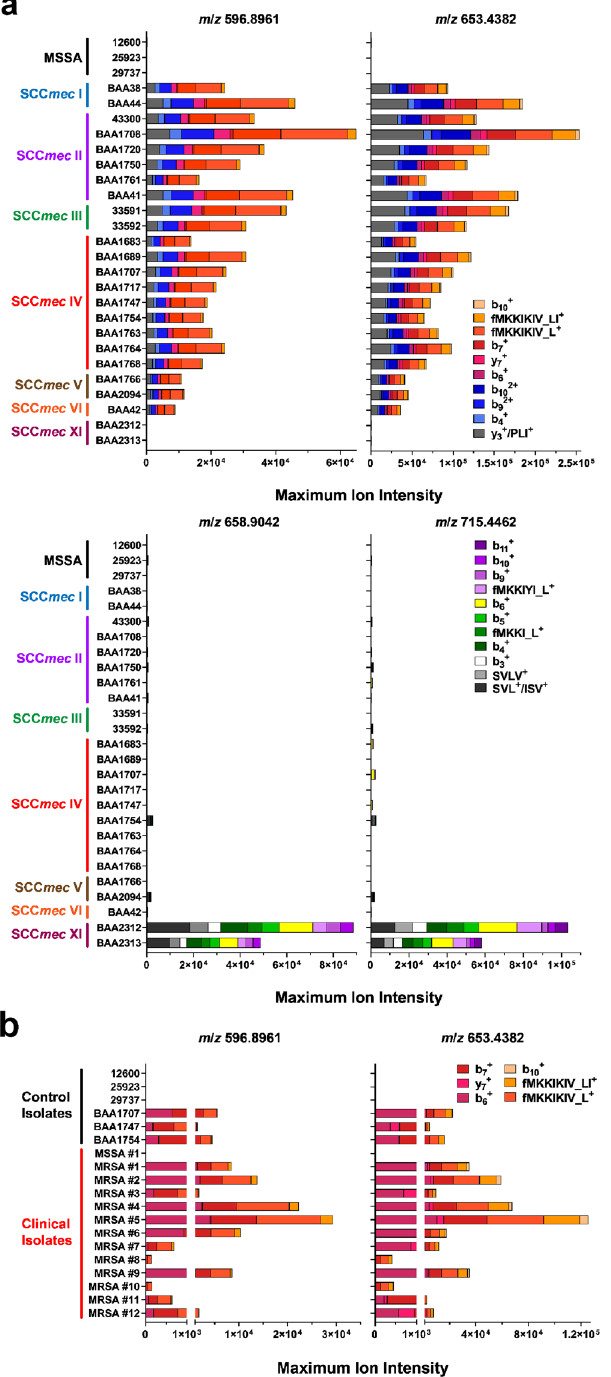
Figure 4. Evaluation of source-induced peptide detection of PBP2a across representative MRSA panel and clinical isolates. ( a ) Performance of source-induced detection method for PBP2a mecA (top panel) and PBP2a mecC (bottom panel) N-terminal peptide-like fragments for MRSA strains exhibiting different SCC mec and PFGE genetic backgrounds, as well as negative MSSA isolates (listed in Supplemental Table S6). Strains were cultured on TSA plates and harvest after overnight growth. Colored bars represent the mean maximum intensity for each product ion over a 60-min LC protein separation. Results are from distinct biological replicates (n = 3). ( b ) Performance of MSSA and MRSA quality control strains along with clinical isolates over five-minute PBP2a mecA detection method using custom SPE trap and source-induced dissociation method. Strains were cultured on Blood Agar plates and harvested after overnight growth. Data are the mean maximum ion intensity for each product ion and calculated from distinct biological replicates (n = 2 or